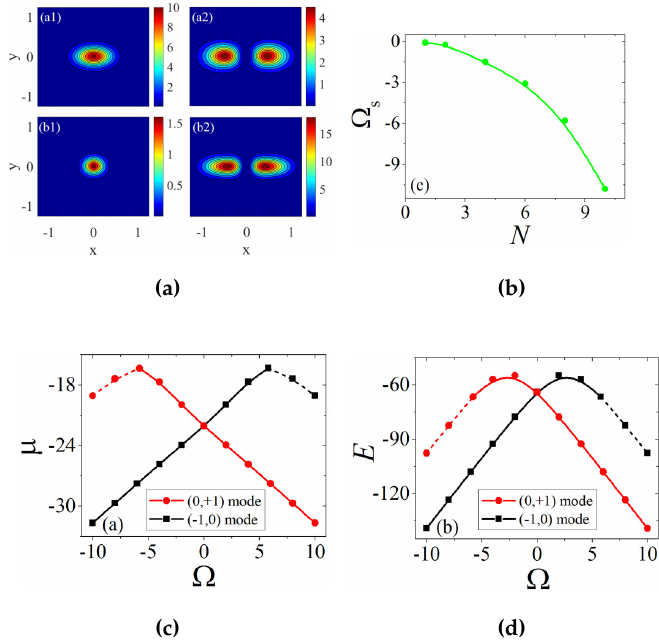
Figure 7. Stable inverted SVS with Ω < 0. ( a ) Density distribution of fundamental and vortex component of inverted SVS with ( Ω , N ) = ( 6, − 1.82 ) (first row) and ( Ω , N ) = ( 10, − 10.8 ) (second row); ( b ) stable threshold Ω s versus N ; ( c ) chemical potentials of the SVS with vortices in ψ + and ψ − components ( S + , S − ) = ( 0, + 1 ) and its flip counterpart ( S + , S − ) = ( − 1,0 ) vs. Ω ; ( d ) the same as in (c), except for total energy E vs. Ω